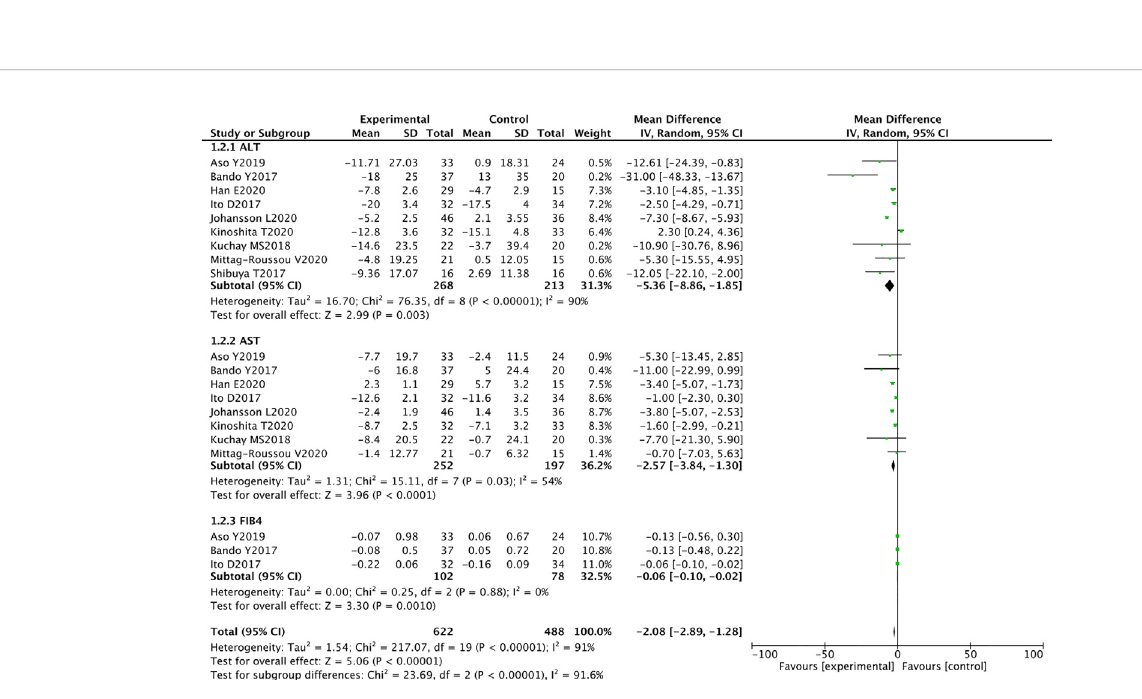
Frontiers in Endocrinology |